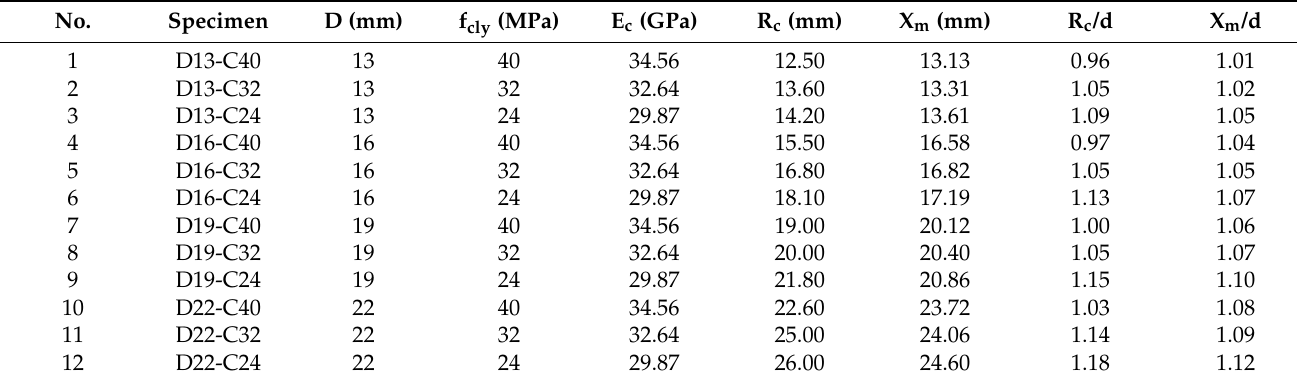
Table 1. Comparison of the concrete plastic